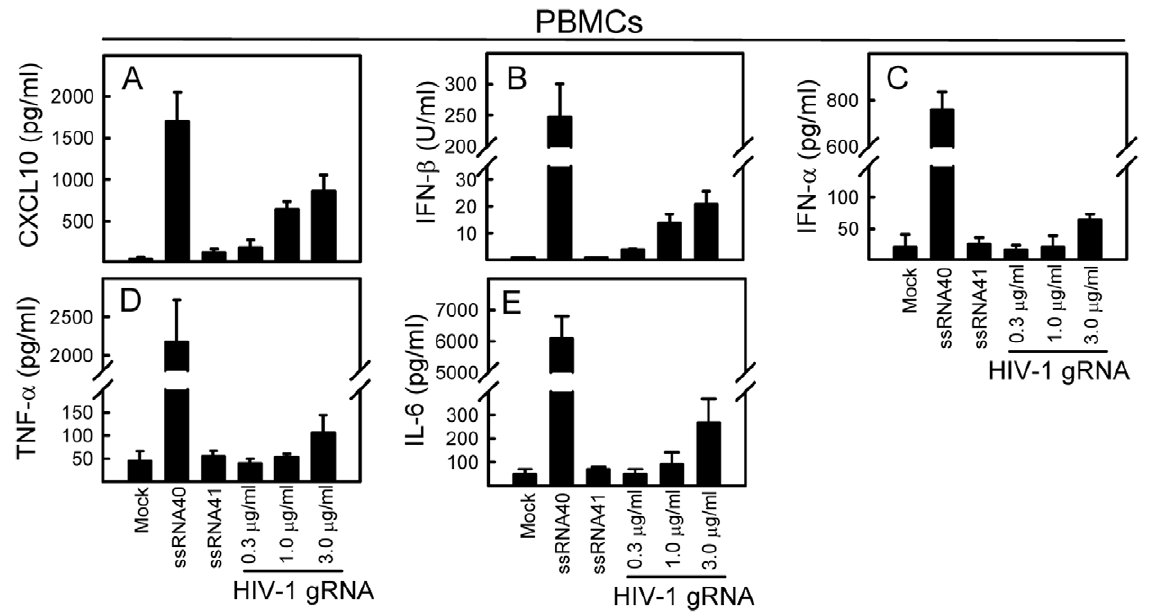
Figure 1. Genomic HIV RNA induces innate immune responses dominated by ISGs. PBMCs were stimulated for 16 h with HIV genomic RNA in increasing doses (from 0.3 to 3.0 m g/ml). Positive and negative controls included ssRNA40 (2 m g/ml) and ssRNA41 (2 m g/ml), respectively. Supernatants were harvested for measurement of (A) CXCL10, (B) IFN- b , (C) IFN- a , (D) TNF- a , and (E) IL-6. Data are shown as means of triplicates + / 2 st.dev. Similar results were obtained in two or three independent experiments. Mock, Lipofectamine 2000 alone. (Fig. 2H–I), and also stimulated expression of IL-1 b mRNA to largely the same extent as the dsRNA mimic Polyinosinic:polycy- tidylic acid (poly(I:C)), which was used as a positive control (Fig. 2J). Although detectable, more modest levels of type I (IFN- b ) and type III IFN (IFN- l 1) were induced by HIV Tar compared to Poly(I:C) (Fig. 2F–G), and the levels of TNF- a mRNA were only affected marginally by the HIV-derived RNA (Fig. 2K).